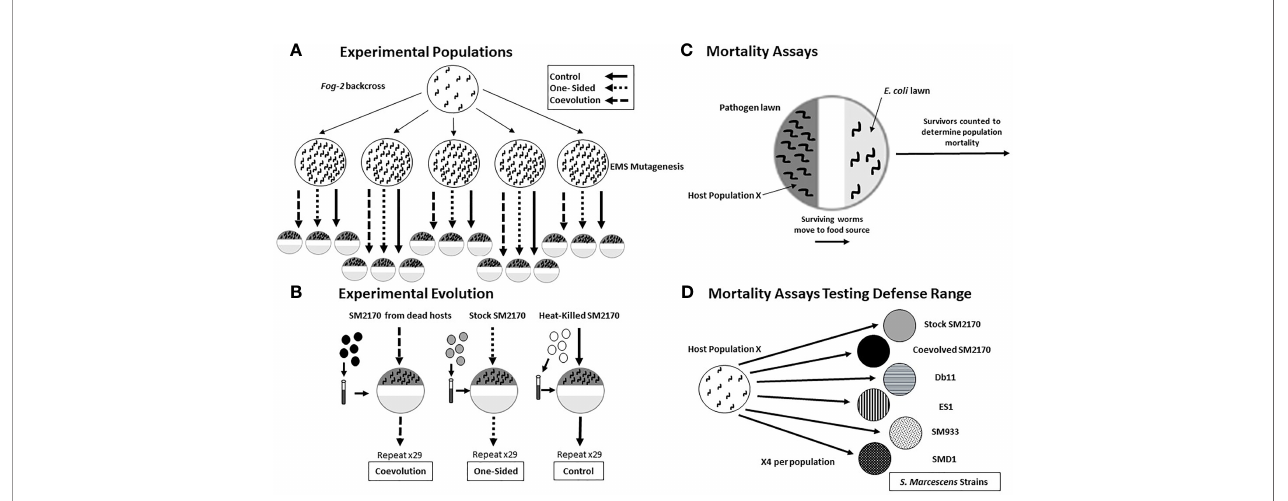
FIGURE 1 | Experimental Overview. (A) The fog-2 allele was backcrossed into inbred CB4856 strain C. elegans , which were subsequently mutagenized to induce variation. After several rounds of reproduction to purge deleterious mutations, worms were separated into 5 groups. Each group was then divided into 3 (control, one- sided, coevolution) and subjected to 30 rounds of exposure to their treatment parasite via Serratia Selection Plates. At the end of each round of selection, the surviving C. elegans are moved to the next plate to begin the process again. (B) In the control group, selection plates were seeded using heat killed Serratia SM2170. One-sided treatment plates received their bacterial lawns from a static stock of Serratia SM2170. Coevolving populations were seeded with SM2170 bacterial colonies removed from the guts of killed worms. (C) To determine population resistance, 200 worms were exposed to the same Serratia Selection Plate protocols as in (A) . (D) To assess host range each of our experiential treatments were assayed against 6 Serratia strains. Each of the 5 replicate populations within each treatment were assayed 4 times. However, here worms were not moved to another plate, and instead were